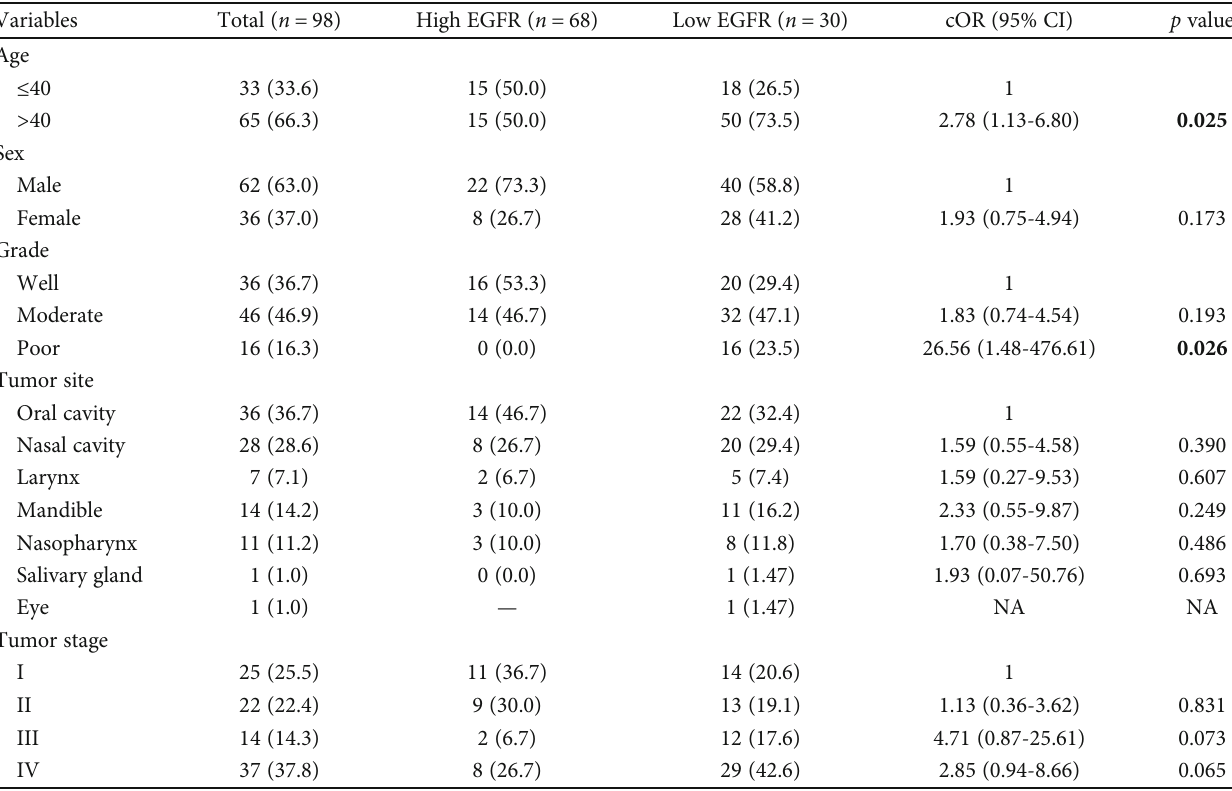
Table 1: Association between EGFR and clinicopathologic characteristics in patients with head and neck malignant tumors.